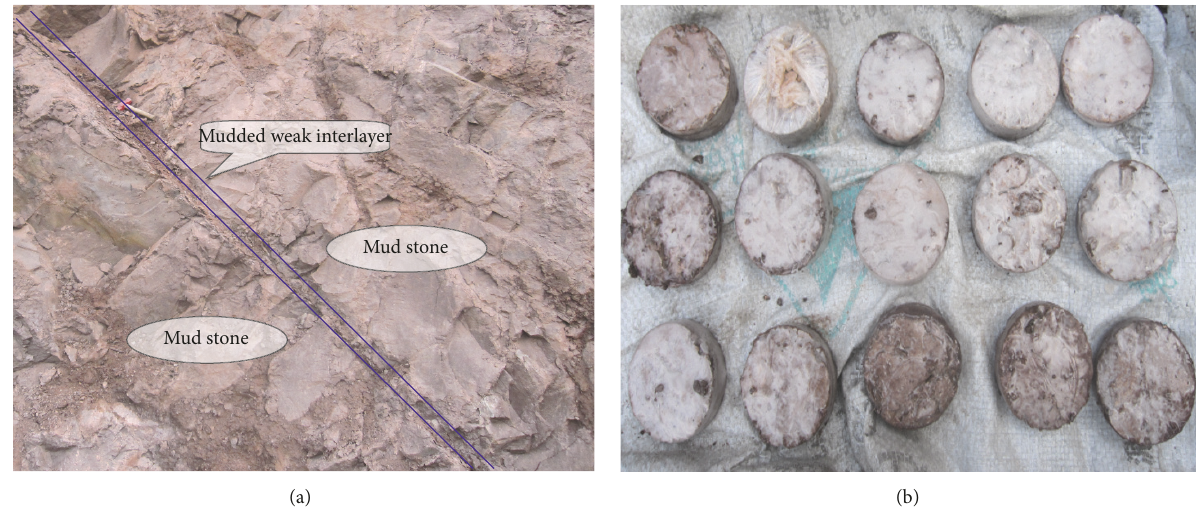
Figure 1: Image of the mudded weak interlayer (a) and mudded weak interlayer specimens